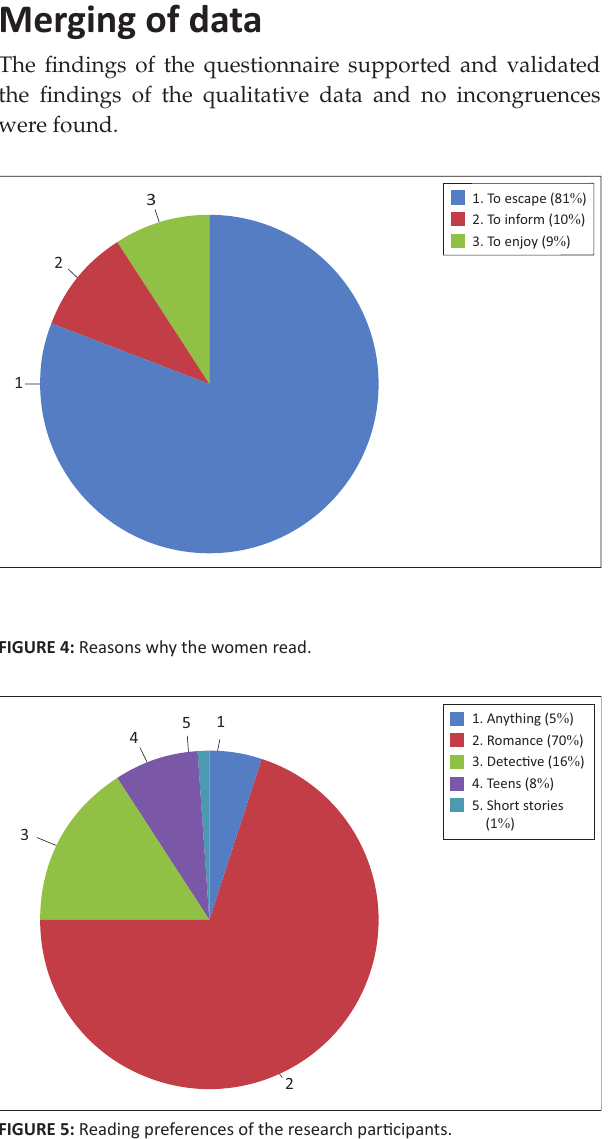
FIGURE 5: Reading preferences of the research participants.